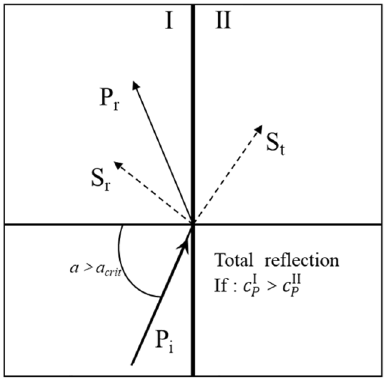
Figure 2. Total reflection of P i .